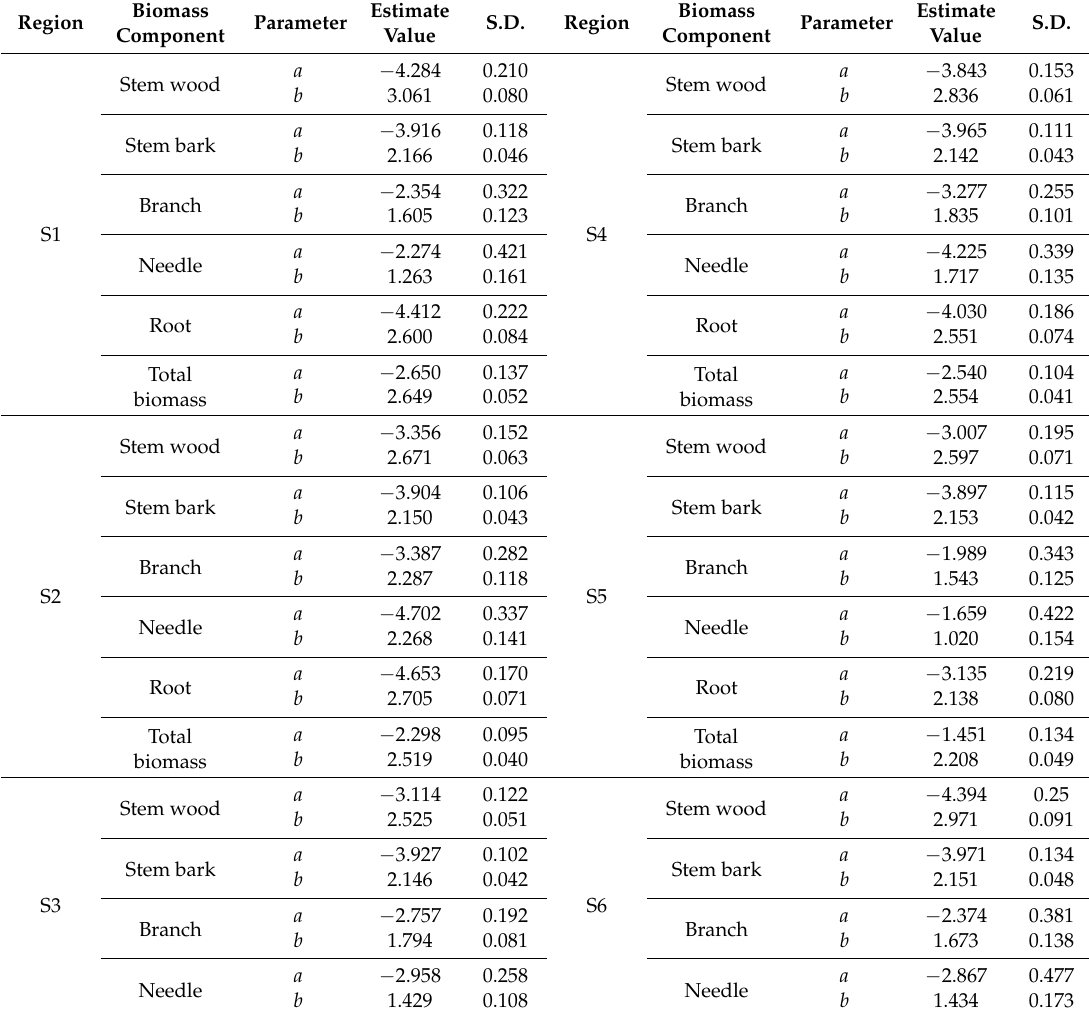
Table 6. Parameter estimates of the Bayesian hierarchical model (Equation